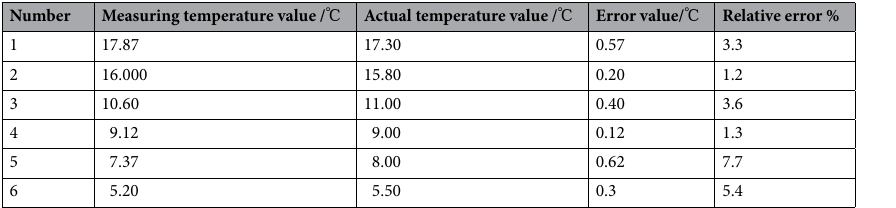
Table 6. Temperature measurement